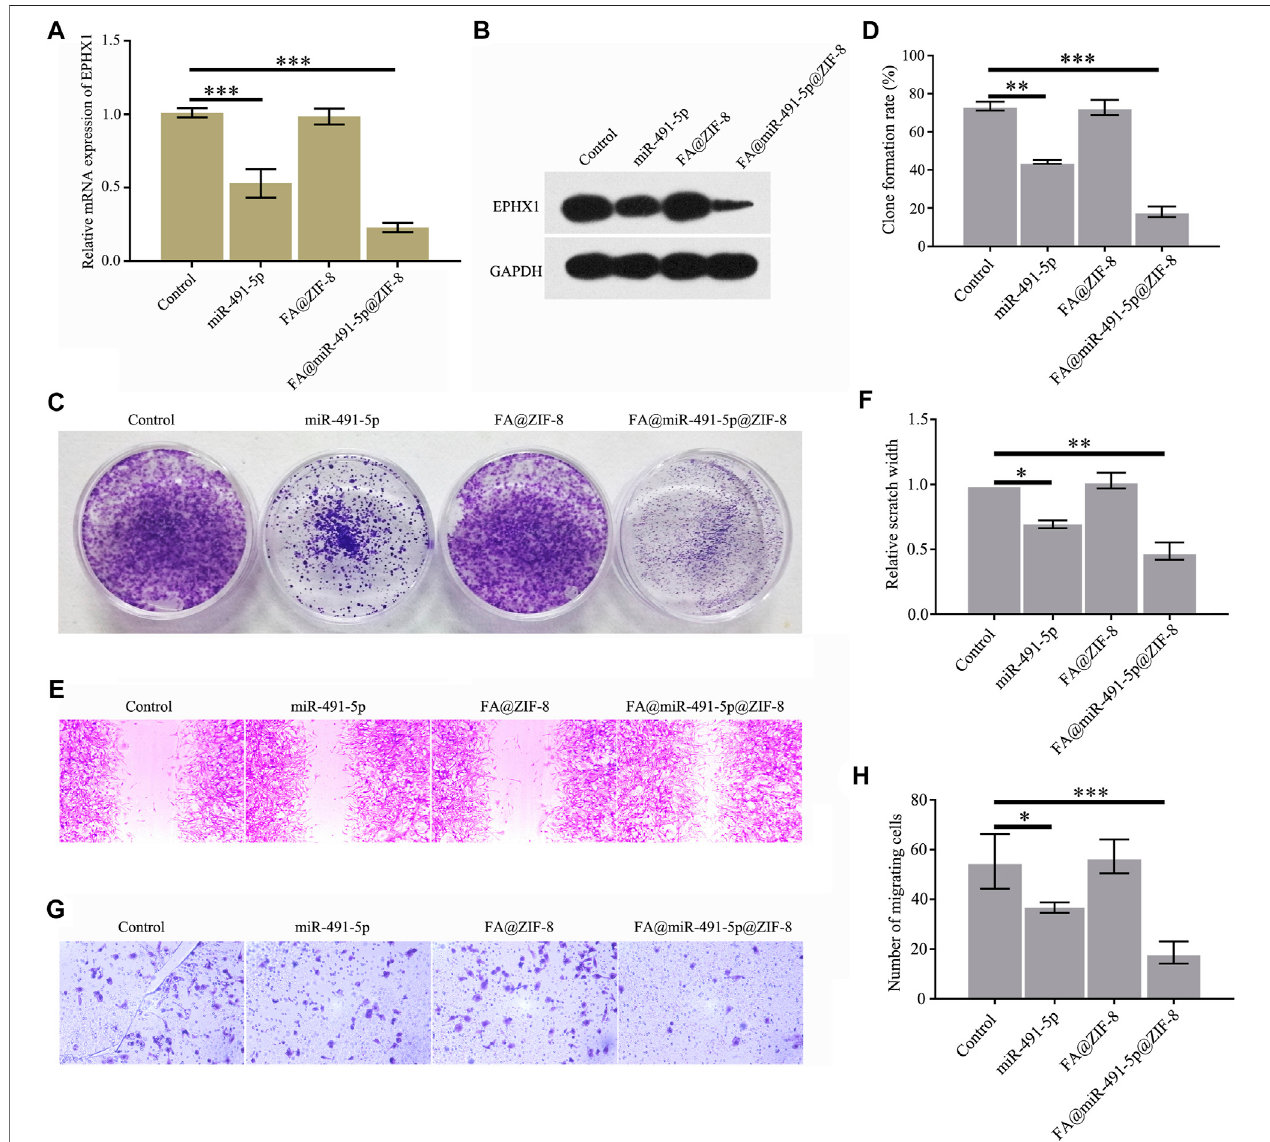
FIGURE 5 | FA@miR-491-5p@ZIF-8 reduced the expression of EPHX1, and proliferation and migration of CRPC cells. (A) QRT-PCR was used to analyze the mRNA expression ofEPHX1inC4-2 cellswhichweretreatedwithFA@miR-491-5p@ZIF-8. (B) Westernblot wasused toanalyzetheexpression ofEPHX1inC4-2 cells which were treated with FA@miR-491-5p@ZIF-8. (C,D) Cell colony formation experiment indicated that FA@miR-491-5p@ZIF-8 inhibited the proliferation of C4-2 cells. (E,F) Cellscratchand (G,H) TranswellassaysshowedthatFA@miR-491-5p@ZIF-8inhibitedthemigrationofC4-2cells.Dataareexpressedasthemean ± SD(* p < 0.05, ** p < 0.01, and *** p <